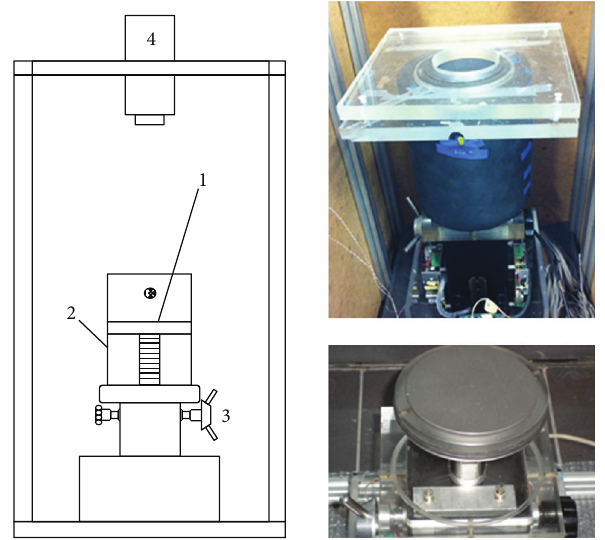
Figure2:AviewoftheTheCotexapparatus:(1)hotplate;(2)PMMA cylinder; (3) control mechanism for raising/lowering the hot plate; (4) IR